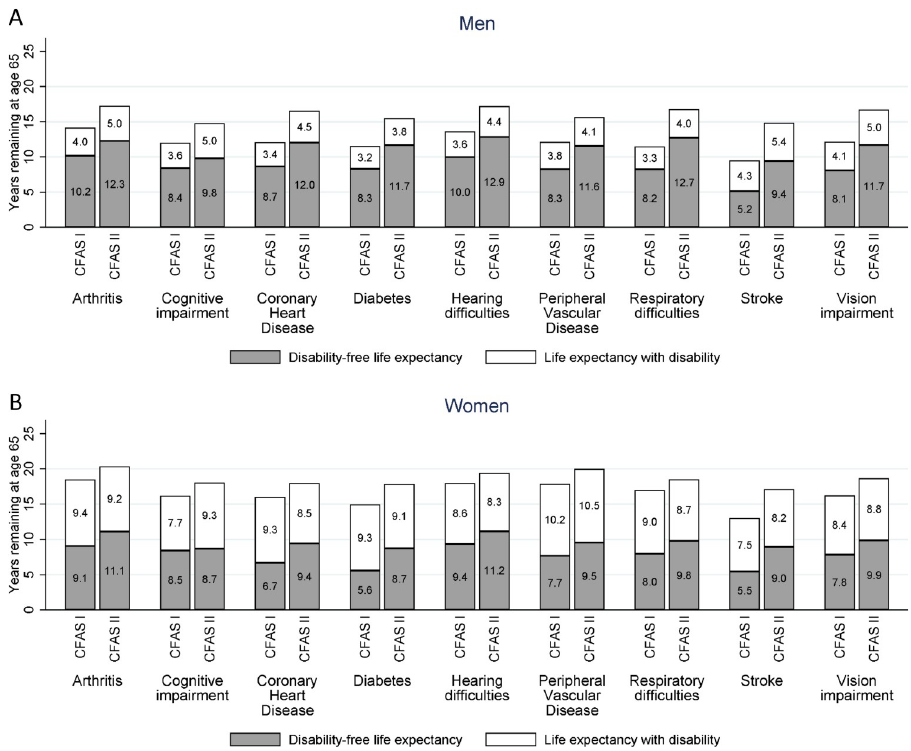
Fig 1. DFLE and DLE at age 65 years for men (A) and women (B) with a health condition in the CFAS I and CFAS II. Models stratified by sex and study and adjusted for age and the health condition. Results also shown in Tables C and E in S5 Text with 95% CIs and p -values. CFAS, Cognitive Function and Ageing Study; DFLE, disability-free life expectancy; DLE, life expectancy with disability. Between CFAS I and II, women experienced an increase in LE at age 65 years of 2.1 years (95% CI: 1.1 to 3.0 years, p < 0.001), with an almost equal increase in DFLE of 2.0 years (95% CI: 1.0 to 2.9 years, p < 0.001) [2]. Women without any of the health conditions at age 65 years had a LE of 21.8 years (95% CI: 19.3 to 24.3) and could expect 15.3 of those years (95% CI: 13.1 to 17.4) to be disability-free in CFAS I. By CFAS II, LE reached 23.9 years (95% CI: 21.1 to 26.8) with 17.0 years DFLE (95% CI: 15.5 to 18.6). Women aged 65 without any health condi- tions gained 2.1 years LE (95% CI: − 1.6 to 5.9, p = 0.26) and 1.8 years DFLE (95% CI: − 0.9 to 4.4, p = 0.20). Similar to men, most improvement in LE at age 65 years for women with each LTC was in disability-free years. While there was no reduction in DLE for men with health conditions, women with some conditions did see a reduction in DLE (Fig 1B, Table E in S5 Text). For example, women with CHD experienced a decline in DLE ( − 0.8 years, 95% CI: − 3.1 to 1.6, p = 0.50) (Fig 1B), resulting in an increase in percentage of remaining years spent dis- ability-free (CFAS I: 42.1%, CFAS II: 52.6%, difference 10.5%, 95% CI: 5.2 to 15.8, p < 0.001) (Table F in S5 Text). The largest gains in DFLE occurred in women with stroke (3.5 years, 95% CI: 0.4 to 6.6, p = 0.03) (Fig 1B, Table E in S5 Text), but this gain was not as large as for men (4.3 years). Women with cognitive impairment experienced a large increase in DLE (1.6 years, 95% CI: 0.1 to 3.1, p = 0.04) without any improvement in DFLE (Fig 1B, Table E in S5 Text). Consequently, the percentage of remaining years disability-free decreased for women with cognitive impairment (CFAS I: 52.2%, CFAS II: 48.3%, difference − 3.9%, 95% CI: − 7.6 to 0.0, p = 0.04) (Table F in S5 Text).